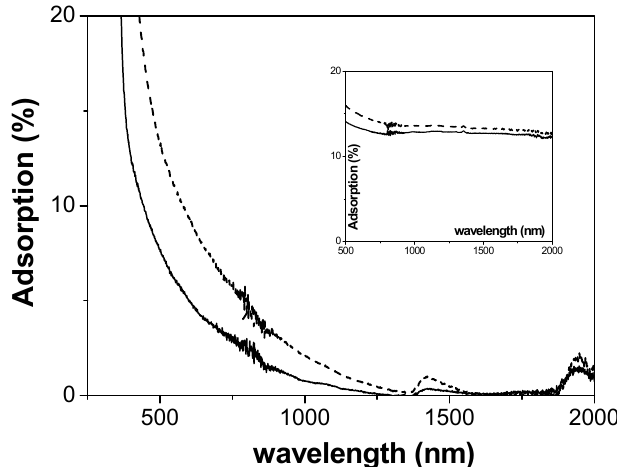
Figure 11. Comparison of light absorption spectra for Sf-NPAM/TiO 2 fouled membrane (solid line) and Ox-NPAM/TiO 2 fouled membrane (solid line). Insert: comparison of absorption spectra for Sf-NPAM (solid line) and Sf-NPAM (dashed line) samples.